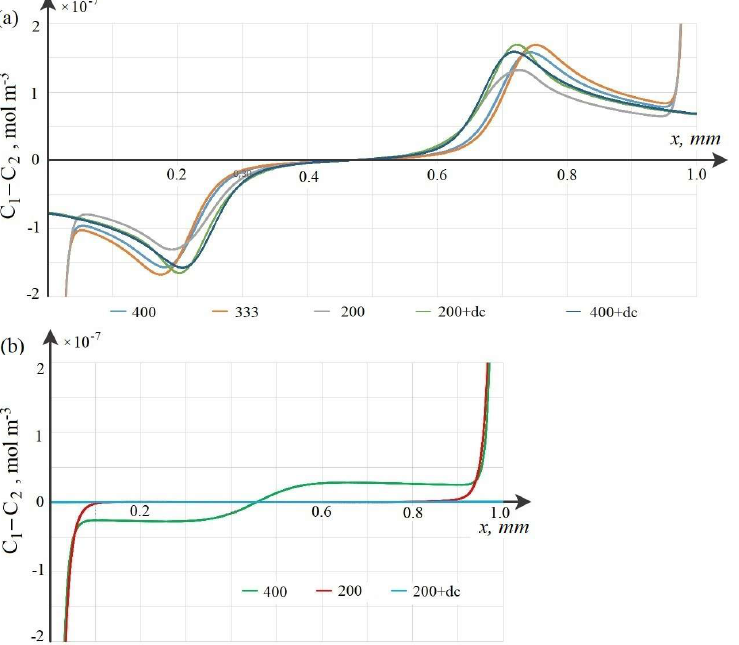
Figure 3. Calculations at different time intervals: before breakdown ( a ), on the eve of breakdown and after breakdown ( b